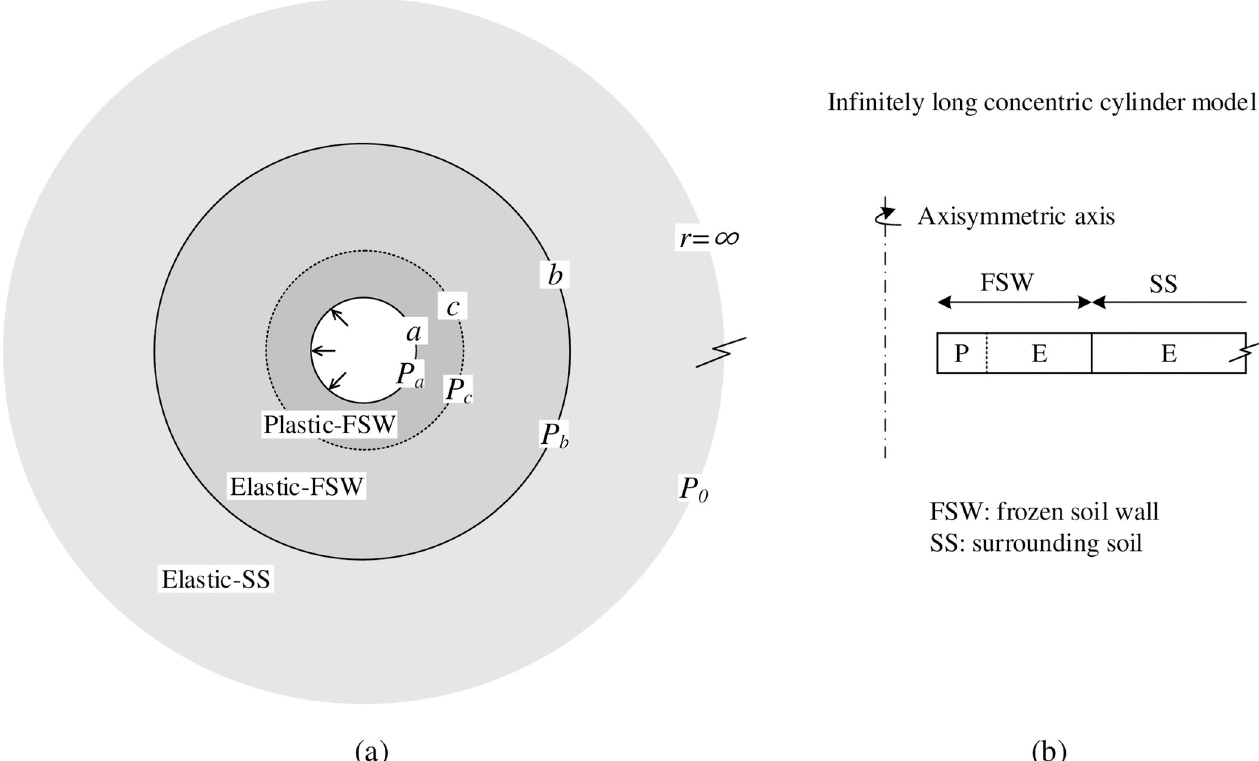
Fig 1. Infinitely long concentric cylinder model for cavity